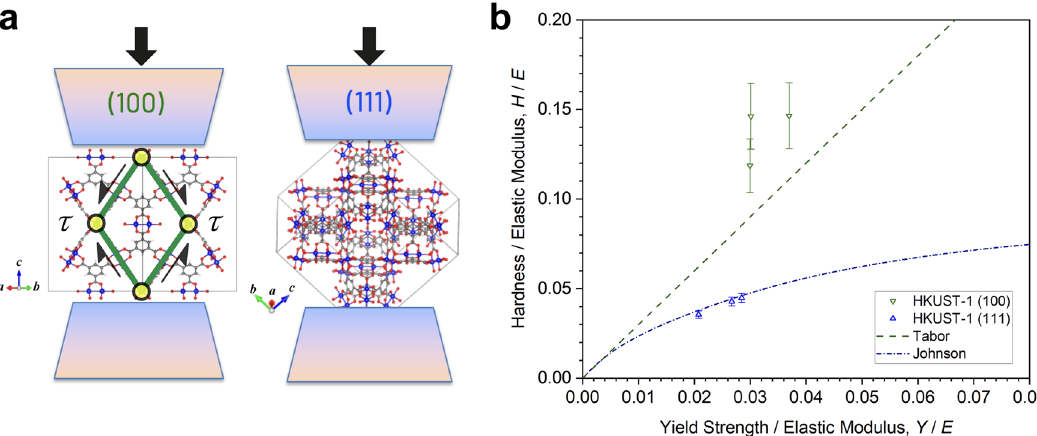
Fig. 2 Mechanical anisotropy of (100) and (111) crystal facets. a Schematics (not to scale) showing the plausible source of mechanical anisotropy associated with the directional effects in the HKUST-1 framework when compressing the framework structure on the (100)- and (111)-crystal facets. Orientations susceptible to shear-induced framework distortions are designated as τ by two pairs of shear stresses. Copper paddlewheel SBUs are denoted by yellow nodes (joints), while BTC linkers in green. Color scheme for atoms: copper in blue, oxygen in red, carbon in grey, hydrogen in white. b H/E vs. Y/E for the two HKUST-1 facets in comparison with the Tabor and Johnson correlations. The error bars represent the standard